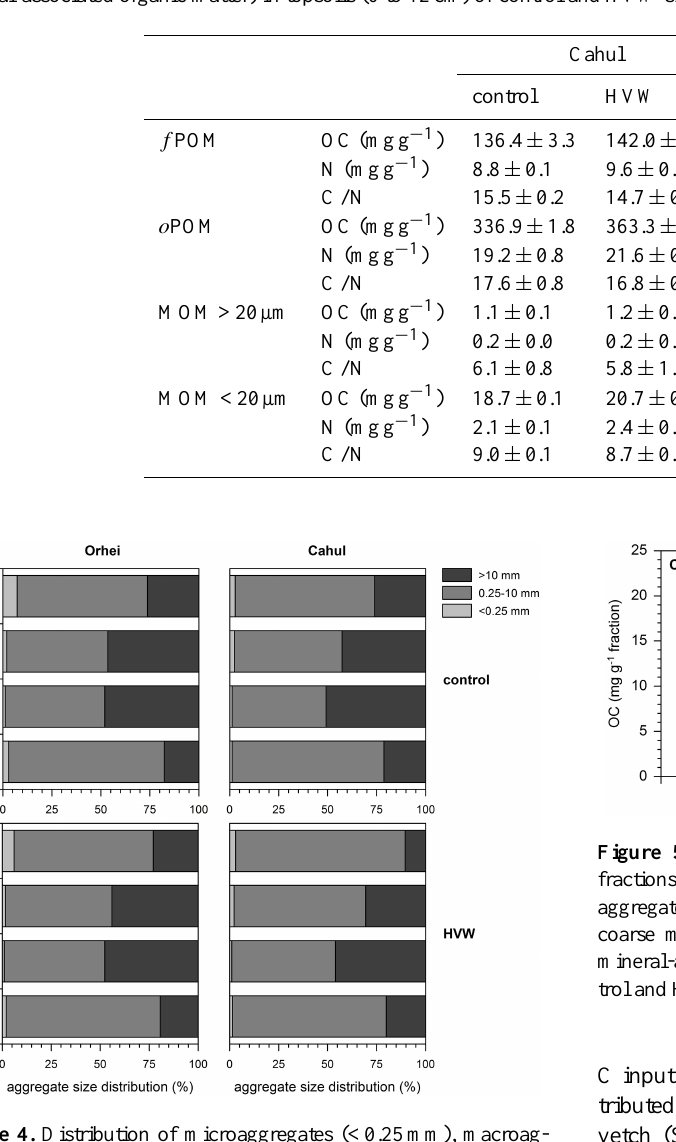
Figure 4. Distribution of microaggregates (<0.25mm), macroag- gregates (0.25–10mm) and clods (>10mm) in topsoil horizons of control and experimental sites in Orhei and Cahul after incorpora- tion of HVW and harvest of the main crop.